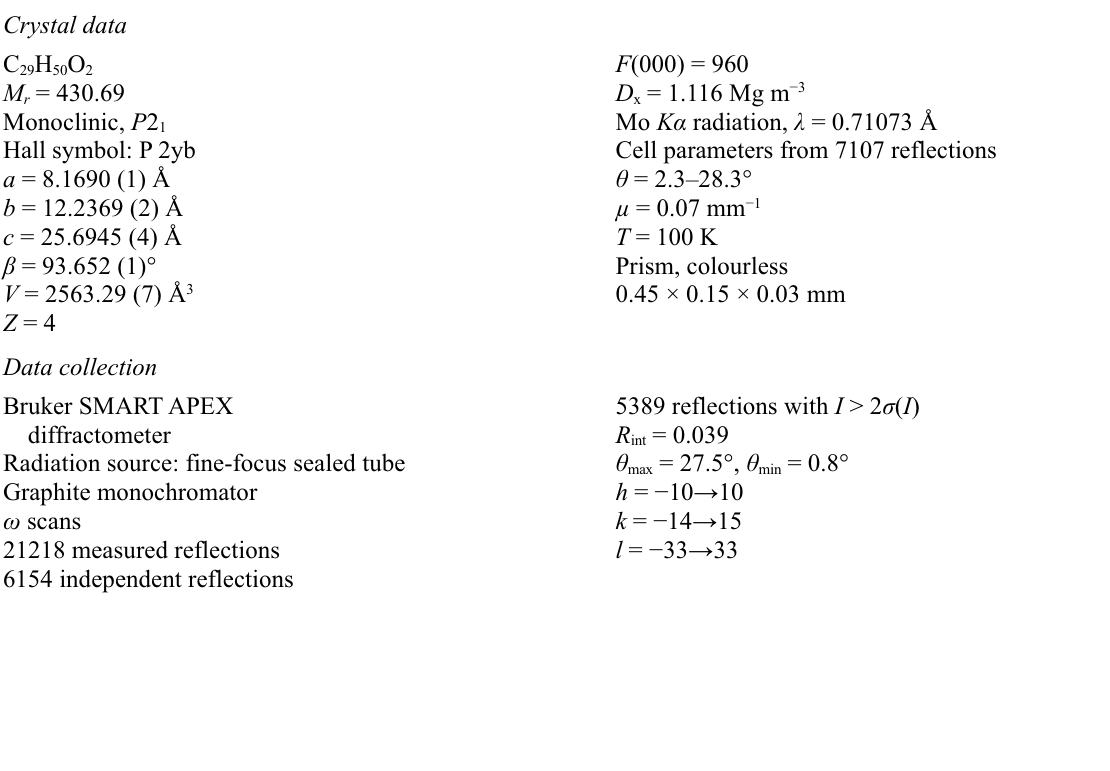
H O . Hydrogen atoms are drawn as spheres of 29 50 2